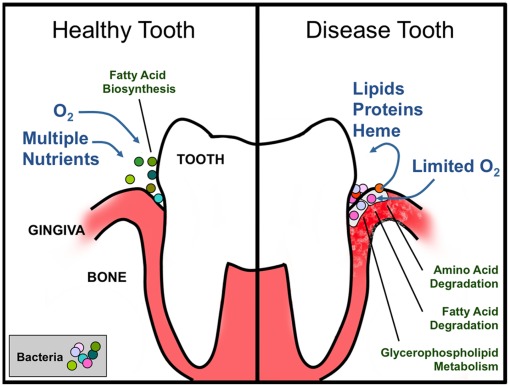
Schematic representation of the putative metabolic lifestyle shifts associated with the change in microbial flora around the tooth and gum tissue upon the transition from a healthy (A) to an advanced periodontal disease (B) state.The healthy state is dominated by the bacterial genera Streptococcus, Fusobacterium, Actinomyces, and Corynebacterium, whereas the disease state is primarily dominated by pathogenic genera such as Prevotella, Leptotrichia, Treponema, and Fusobacterium.